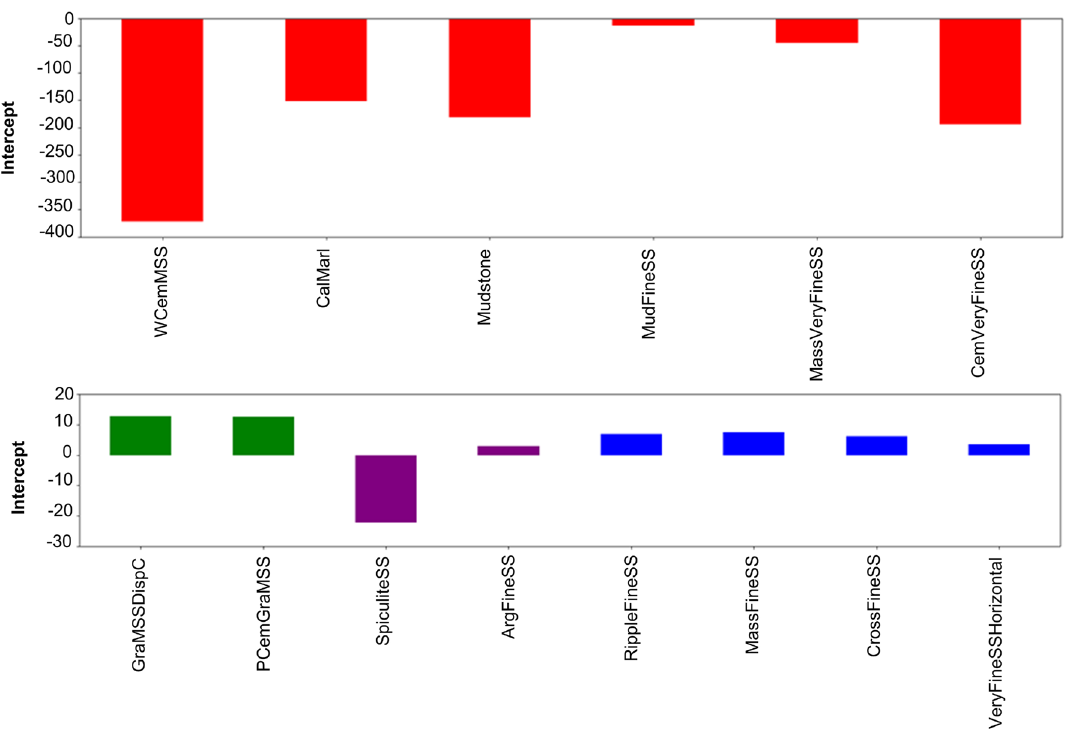
Fig. 12 Intercept values computed from the porosity–permeability cross-plot for misclassified lithofacies. Similar lithofacies, misclassified by the classifier, are presented with similar colors corresponding to the lithofacies clusters identified in Fig.